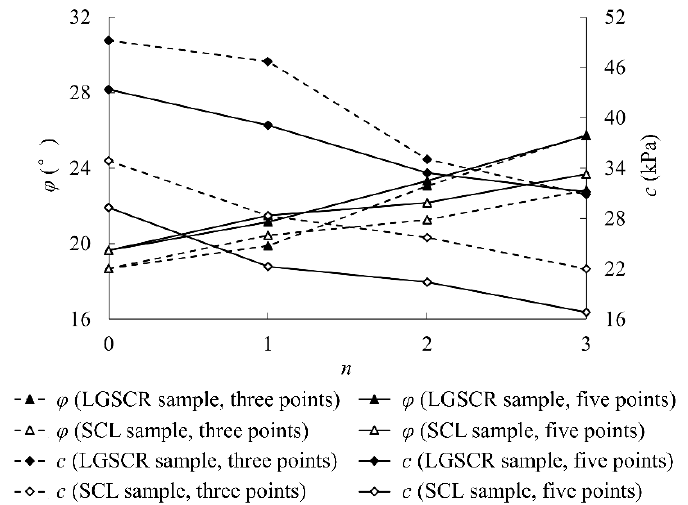
Figure 12. The variation in the shear strength index of the samples with the number of sand